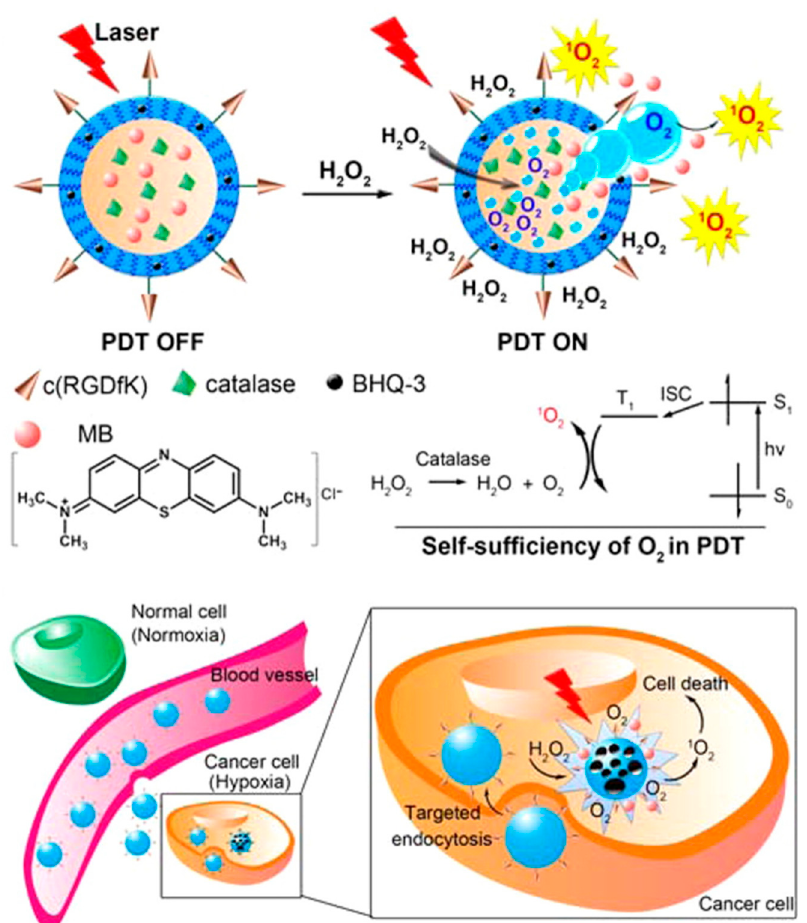
Figure 2. Schematic illustration of self-sufficiency of O 2 in photodynamic therapy (PDT). Reprinted with permission from reference [44]. Copyright 2015 American Chemical Society.